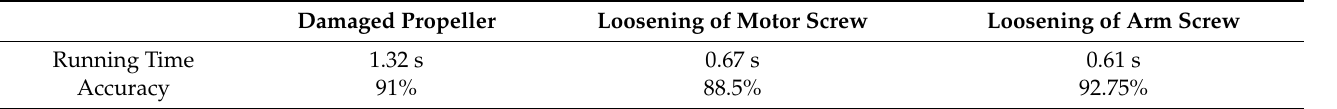
Table 5. The best single fault kNN classification model based on time-domain data analysis.